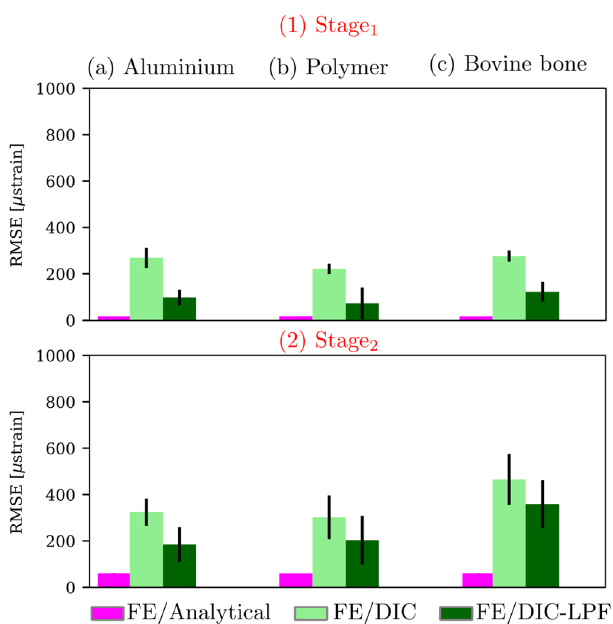
Figure 7. RMSE for the linear strain gradients ROIs at the two deformation stages for the three tested